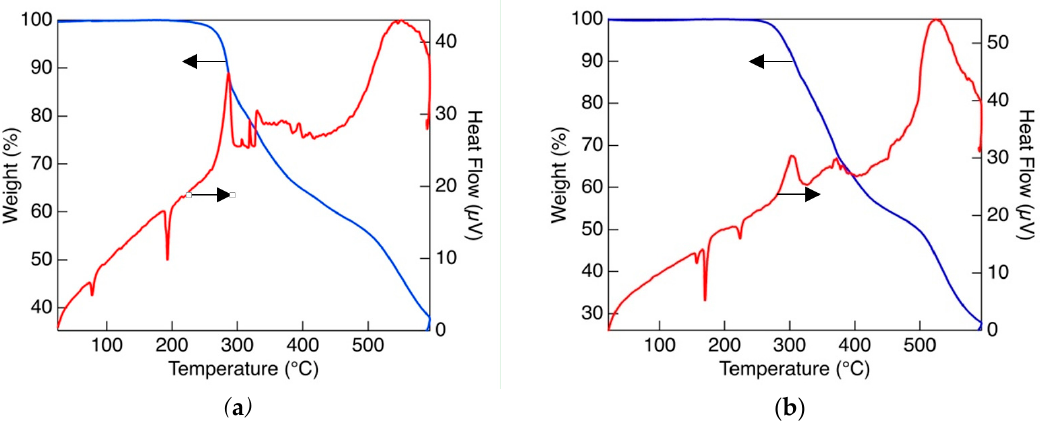
Figure 3. Thermogravimetric/differential thermal analyzer (TG/DTA) thermograms of complexes 3